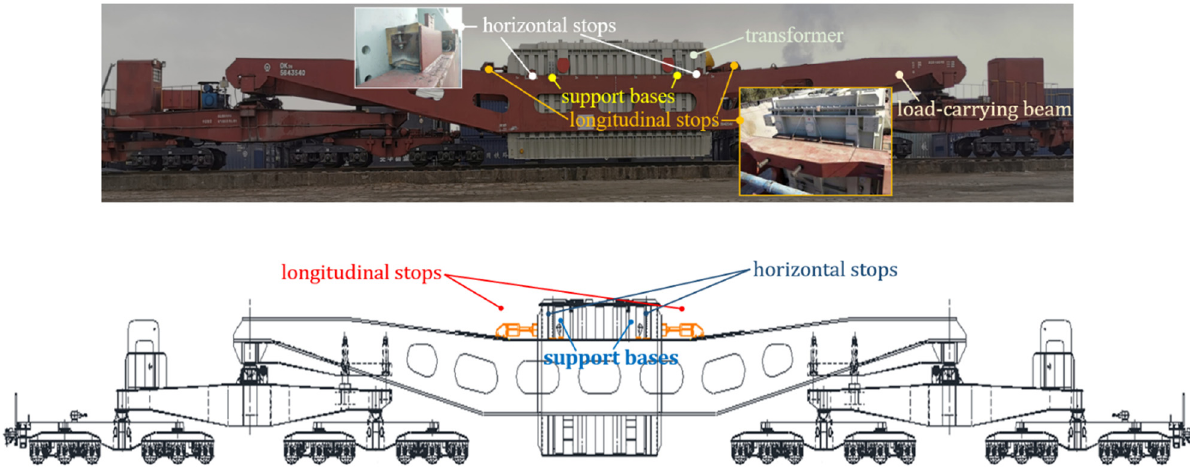
Figure 1: Schematic diagram of heavy haul freight train